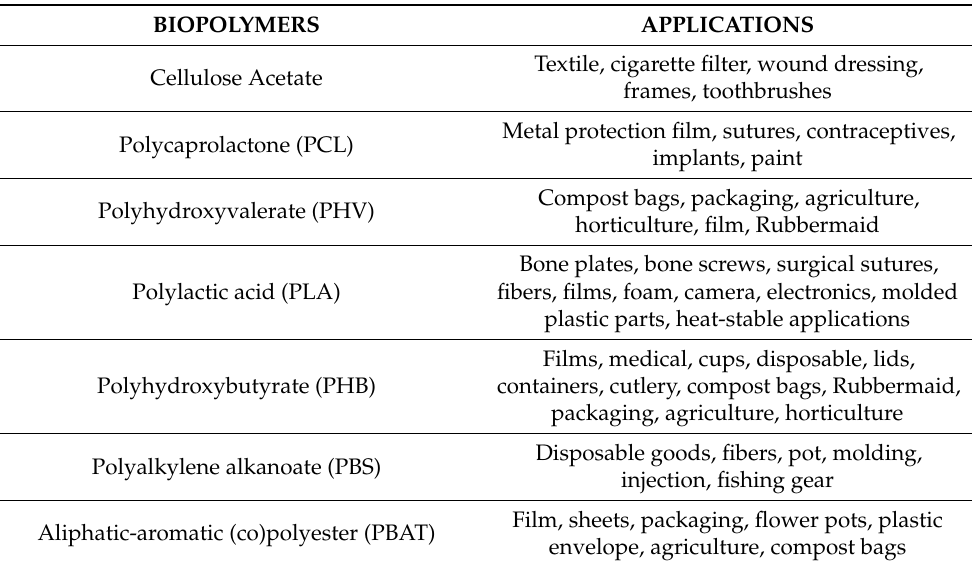
Table 1. Emerging applications of various